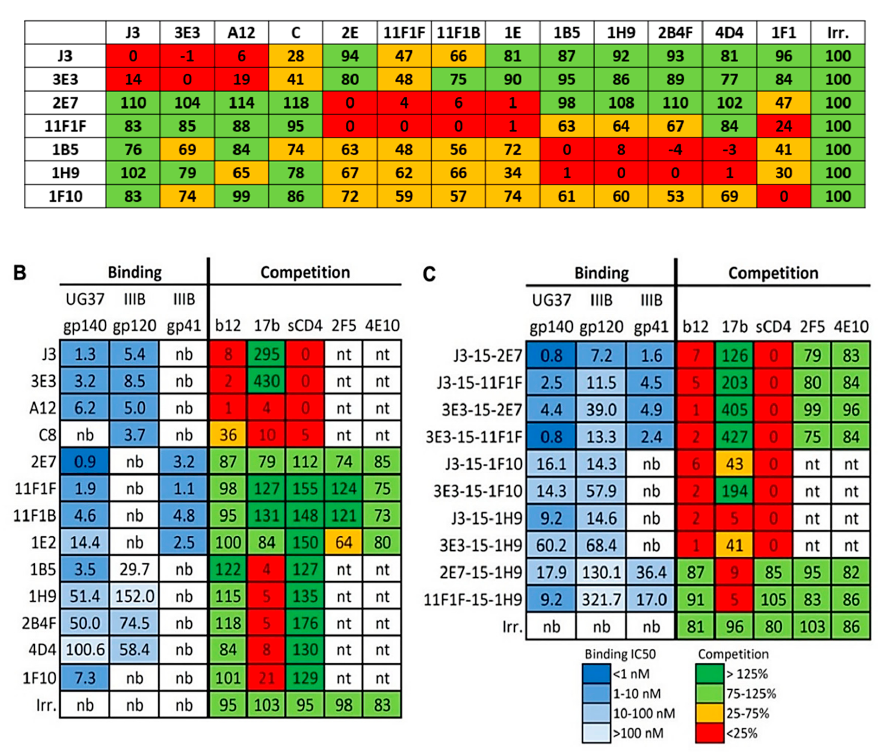
Figure 3. Interaction of the selected VHH with HIV-1 Env proteins. ( A ) Is showing the VHH competition among themselves for binding to gp140UG37, this is presented as a percentage. Gp140UG37 trimers used in this study are non-native trimers that contain a substantial amount of “open” Env structures. The signal observed for VHH competing with themselves was defined as 0%, signal during competition with an irrelevant VHH was defined as 100%. The VHH represented in the columns are the competing VHH, which were present in large excess. The VHH represented in the rows are the detected VHH. ( B , C ) are showing the binding of VHH ( B ) and bi-valent VHH ( C ) to gp140UG37, gp120IIIB and gp41, and their ability to compete with several mAbs and sCD4. Binding is expressed as the IC50 value in nM, competition as a percentage of the signal obtained where no competing VHH was